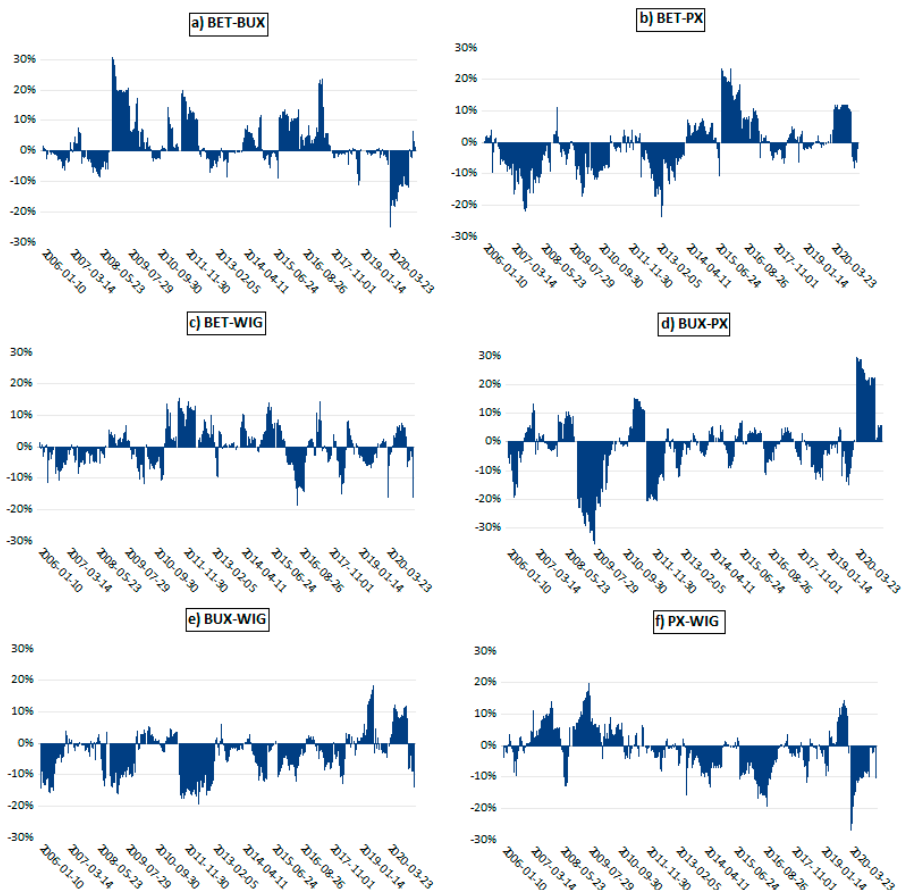
Figure 7. Rolling window estimation of net pairwise spillover (the difference between the volatility transmitted from index i to index j and the volatility transmitted from index j to index i). ( a – f ) represents the relationships between all 6 pairs of stock indexes.